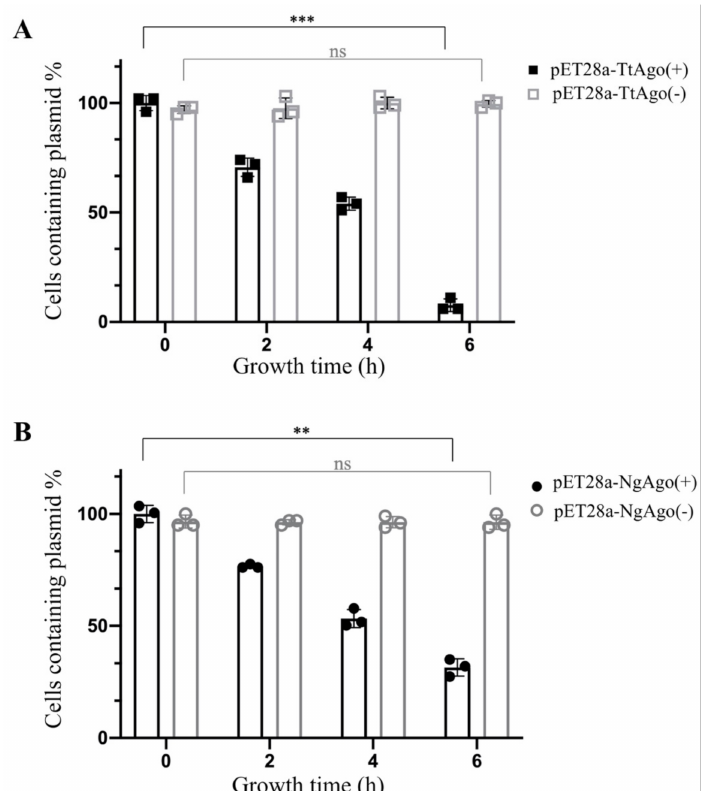
Figure 4. Plasmid maintenance assay of pET28a-TtAgo and pET28a-NgAgo with and without IPTG induction. ( A ) Cells containing pET28a-TtAgo plasmid were calculated before and after different times (2, 4, and 6 h) post-IPTG induction, and without IPTG induction. Legend “pET28a- TtAgo(+)” represents IPTG induction treatment, and legend “pET28a-TtAgo( − )” represents no- induction treatment. The normalization of data was performed with paired-samples t test (means and standard deviations from three independent biological replicates, error bars represent the mean ± s.d. ** p < 0.01, *** p < 0.001, “ns” represents “not significant”.). ( B ) Cells containing pET28a- NgAgo plasmid were calculated before and after different times (2, 4, and 6 h) post-IPTG induction, and without IPTG induction. Legend “pET28a-NgAgo(+)” represents IPTG induction treatment, and legend “pET28a-NgAgo( − )” represents no-induction treatment. The normalization of data was performed with paired-samples t test (means and standard deviations from three independent biological replicates, error bars represent the mean ± s.d., ** p < 0.01, “ns” represents “not significant”. *** p <